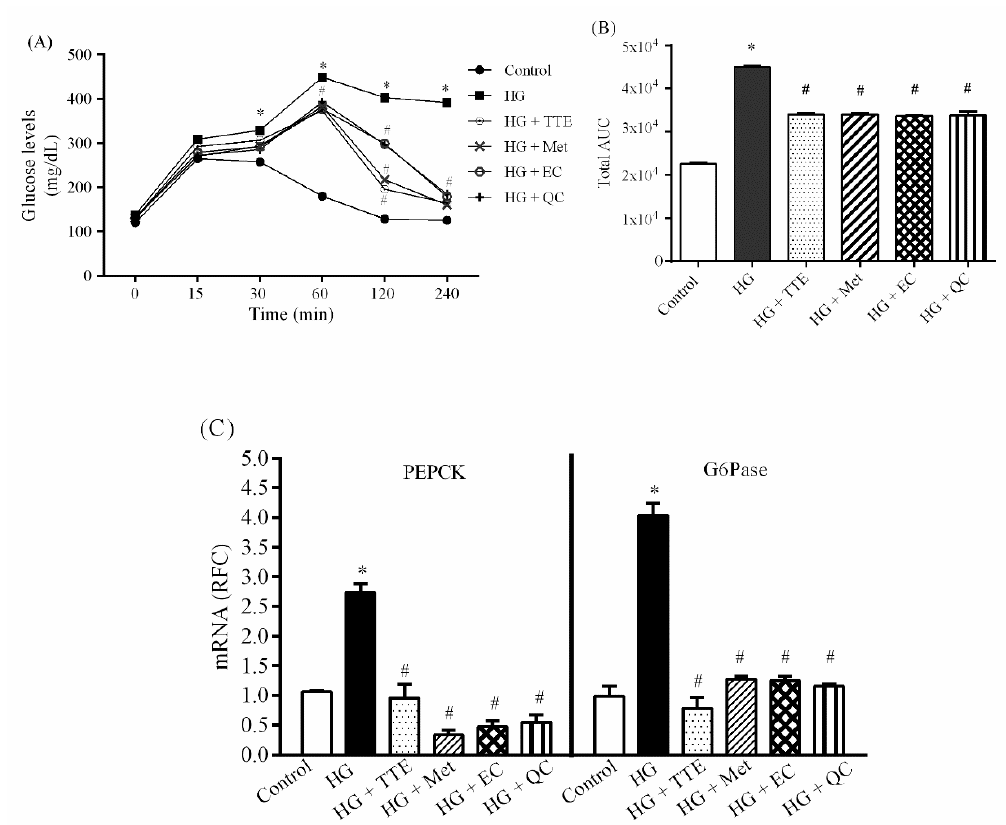
Figure 3. The inhibitory effect of TTE on hepatic glucose production in HepG2 cells. Cells were incubated with or without a medium containing 5 mM glucose (HG) for 24 h. Subsequently, HG cells were treated with 20 mM sodium lactate and 2 mM sodium pyruvate for another 240 min. ( A ) The glucose levels in the media in each condition, including HG cells treated with 100 µ g/mL TTE (HG + TTE), HG cells treated with 2 mM metformin (HG + Met), HG cells treated with 100 µ g/mL epicatechin (HG + EC), and HG cells treated with 100 µ g/mL quercetin (HG + QC) were determined using a commercial colorimetric assay. ( B ) Total area under the curve was calculated from ( A ). ( C ) Phosphoenolpyruvate carboxykinase (PEPCK) and G6Pase mRNA expression from each condition were measured using quantitative real-time PCR (qPCR). The results are reported as RFC and expressed as mean ± SEM ( n = 5). * p < 0.05 vs. the control group, # p < 0.05 vs. the HG group.